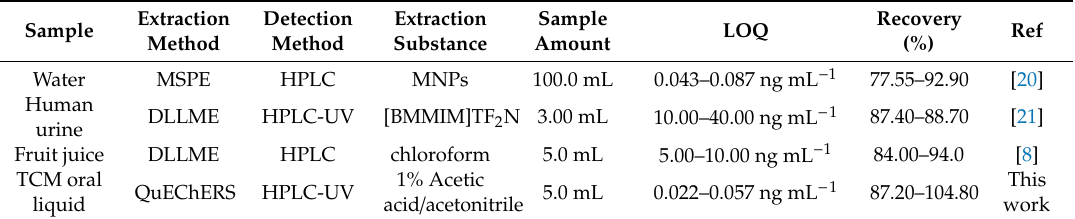
Table 4. Comparison of the QuEChERS method with other methods for the determination of pyrethroids in liquid